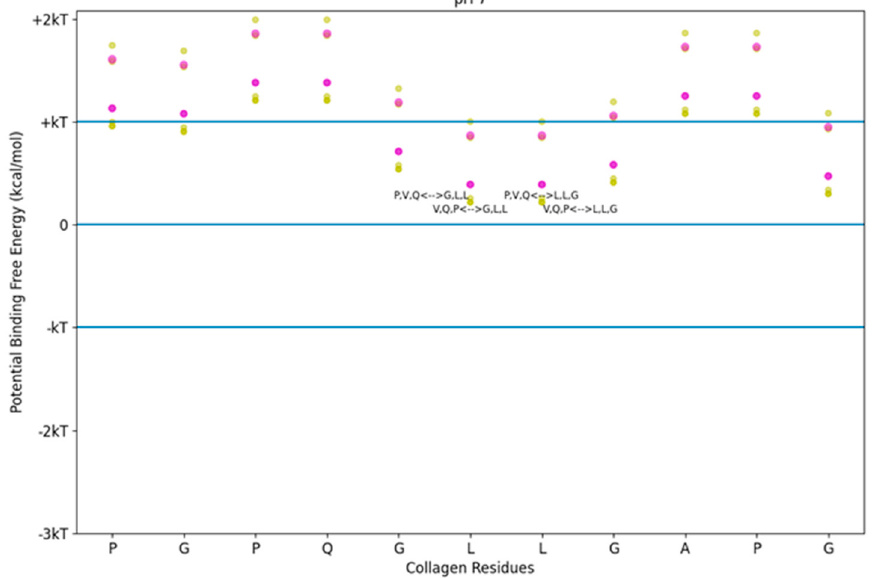
Figure 2. Free energy of binding estimates for sets of three adjacent residues on two different collagen-binding peptides on human collagen type I alpha chain 2 (COL1A2) residues 861–871. Positive binding sites are energetically unfavorable, while negative binding sites are favorable. Binding sites significantly below –kT are likely to be stable. Each circle represents a potential three-amino-acid binding site between a peptide and collagen. The potential binding free energy was calculated from the Wimley–White hydropathy scale values for the amino acids within the binding site. The three-amino-acid binding sites are labeled with the peptide sub-sequence when the potential energy was below + 0.3 kcal/mol. Potential binding sites are gold for collagenase peptide (SQNPVQP) and magenta for the DNA complement peptide (TKKTLRT). The radius of the circle sizes is related to the magnitude of the polarity of the peptide residues. kT, which is the Boltzmann’s constant multiplied by the temperature of 25 °C, is 0.693 kcal/mol. This value is close to a mean estimate of the free energy fluctuations of a surrounding environment near room temperature. The temperature dependence is based on the absolute temperature, so body temperature would have a corresponding kT of about 0.721 kcal/mol (about 4% increase).